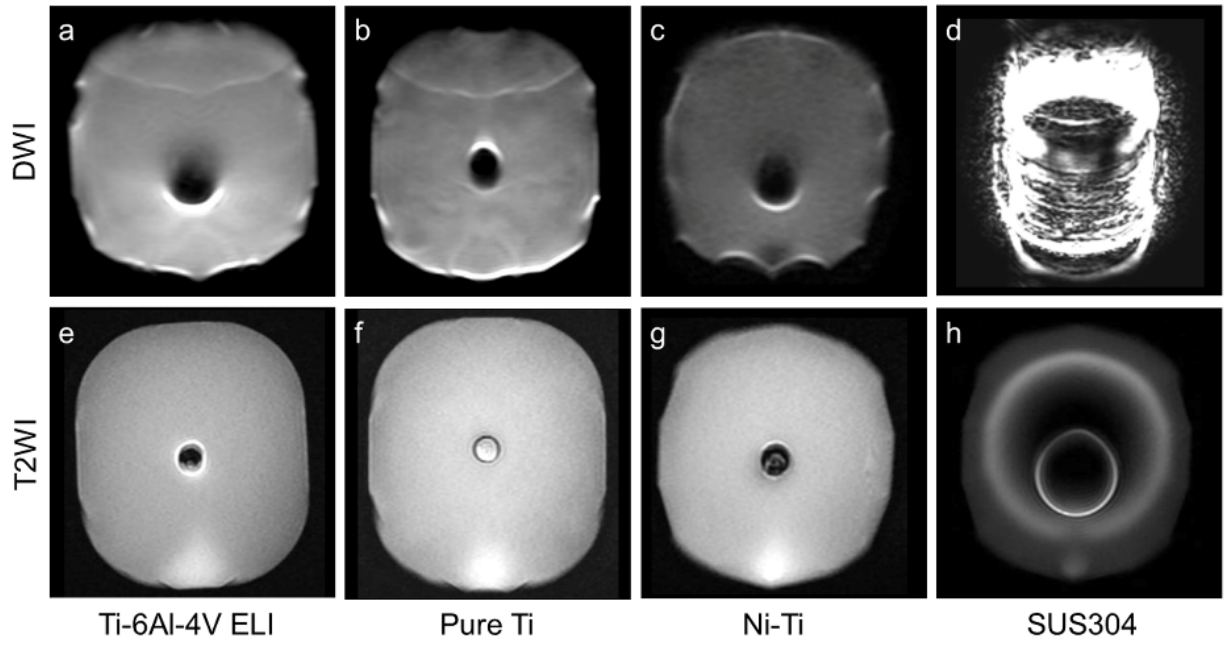
Figure 3. Comparison of the images of metal wires in the phantom on MRI (3.0-Tesla). To evaluate the susceptibility artifacts of various metal wires, axial DWI ( a – d ) and T2-weighted ( e – h ) MRI of helical metal wires was performed: ( a , e ) Ti alloy (Ti-6Al-4V ELI, Ø 0.21 mm) used in our reinforced endotracheal tube, ( b , f ) pure Ti (Ø 0.1 mm), ( c , g ) Ni-Ti alloy (Ni-Ti, Ø 0.1 mm), and ( d , h ) SS (SUS304, Ø 0.1 mm).